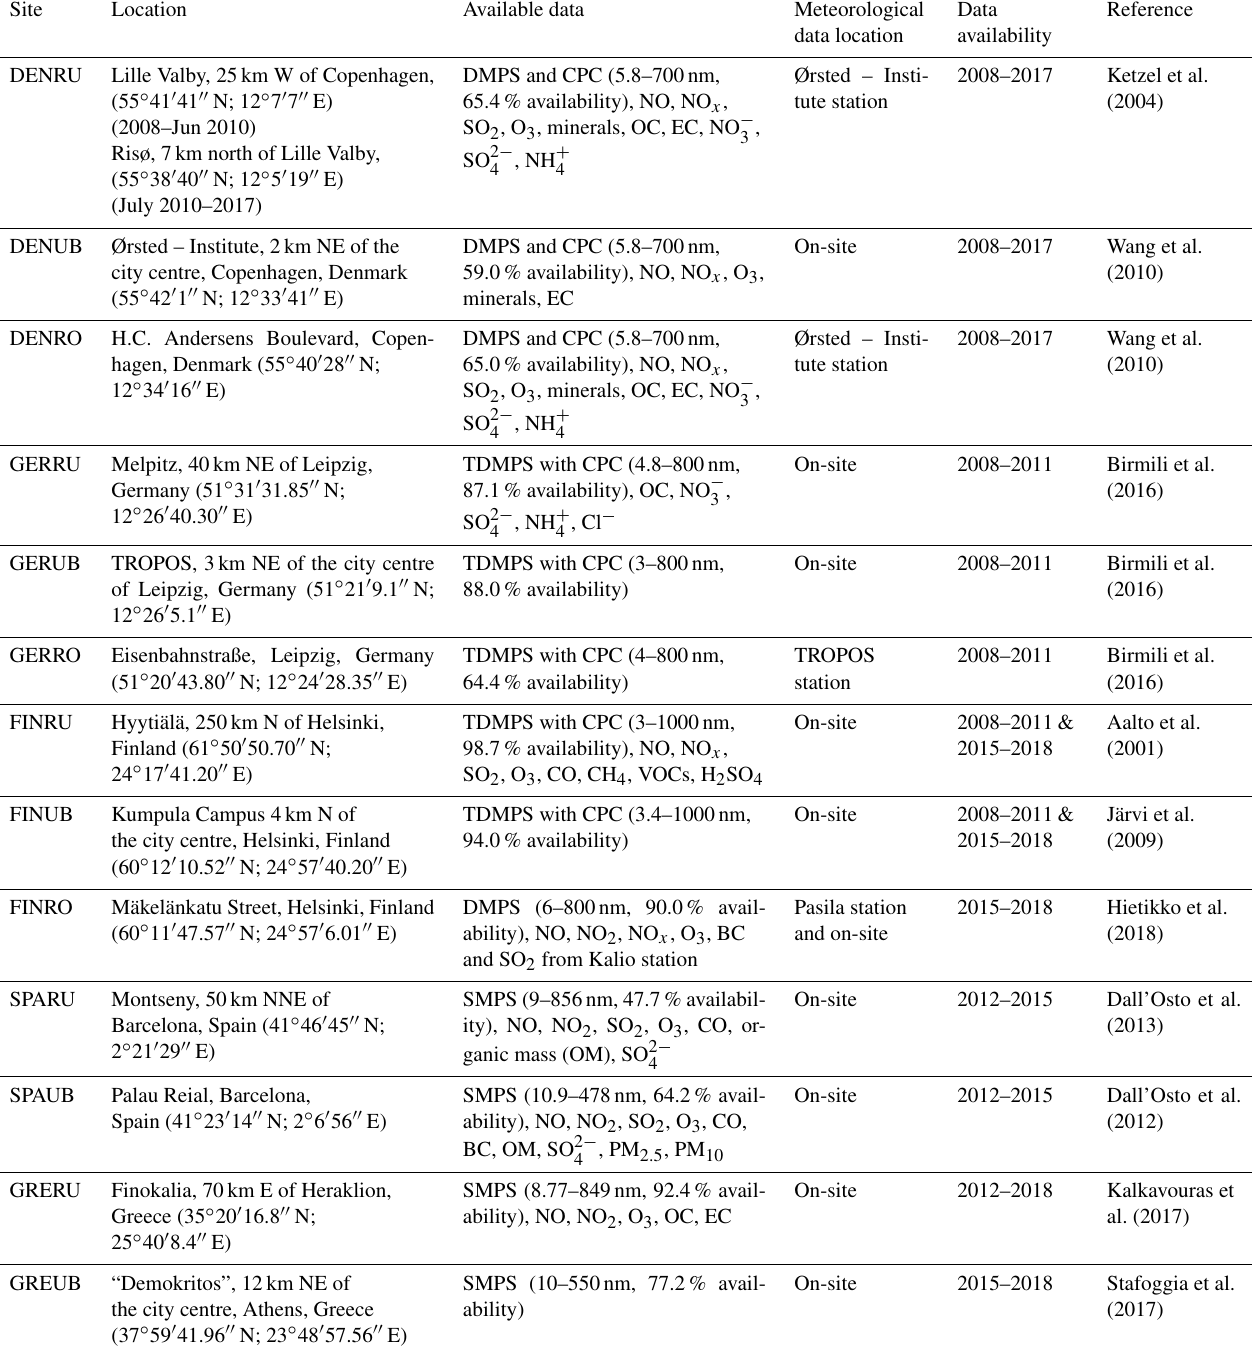
Table 1. Location and data availability (seasonal data availability can be found in Table S4) of the sites in the present study. In the studies referenced, an extended description of the sites can be found (SMPS – scanning mobility particle sizer; DMPS – differential mobility particle sizer; TDMPS – twin differential mobility particle sizer; CPC – condensation particle